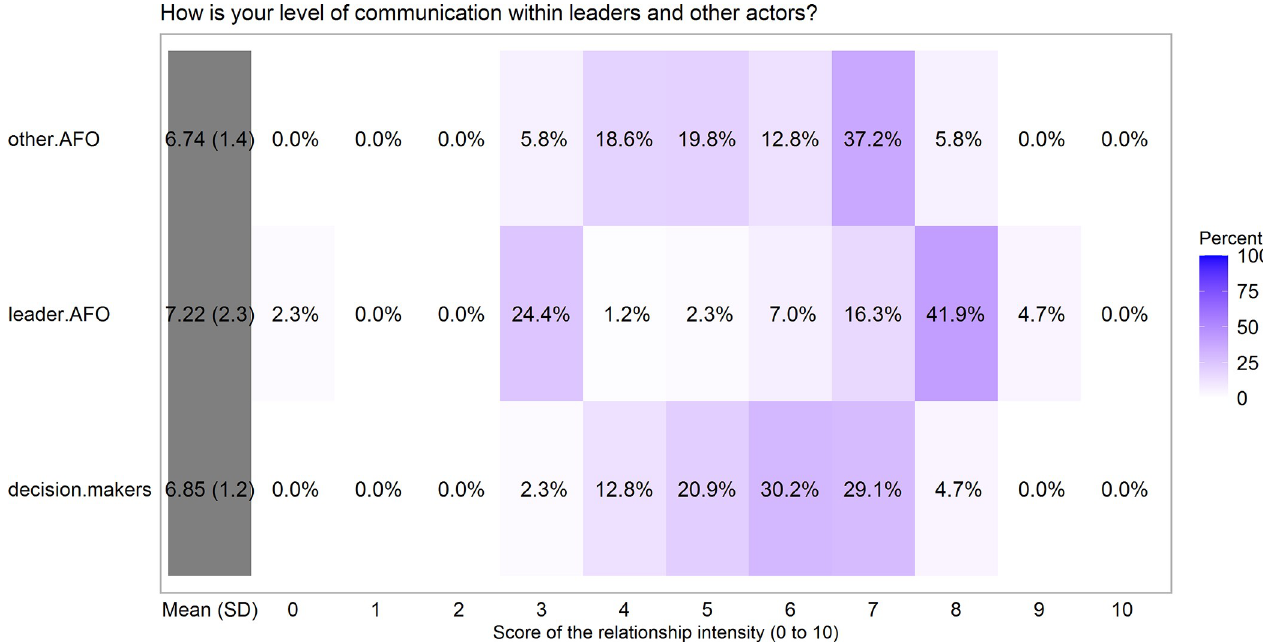
Fig 4. Percentage and mean scores ( ± SD ) of the level of communication between member and other actors. Other actors are leaders of their Artisanal Fisher Organizations (AFOs), non-fishers, and other AFOs of the MEABRs in Biobio Region. Scoring scale is from zero (worst) to 10 (best), a score of 7/10 is a good